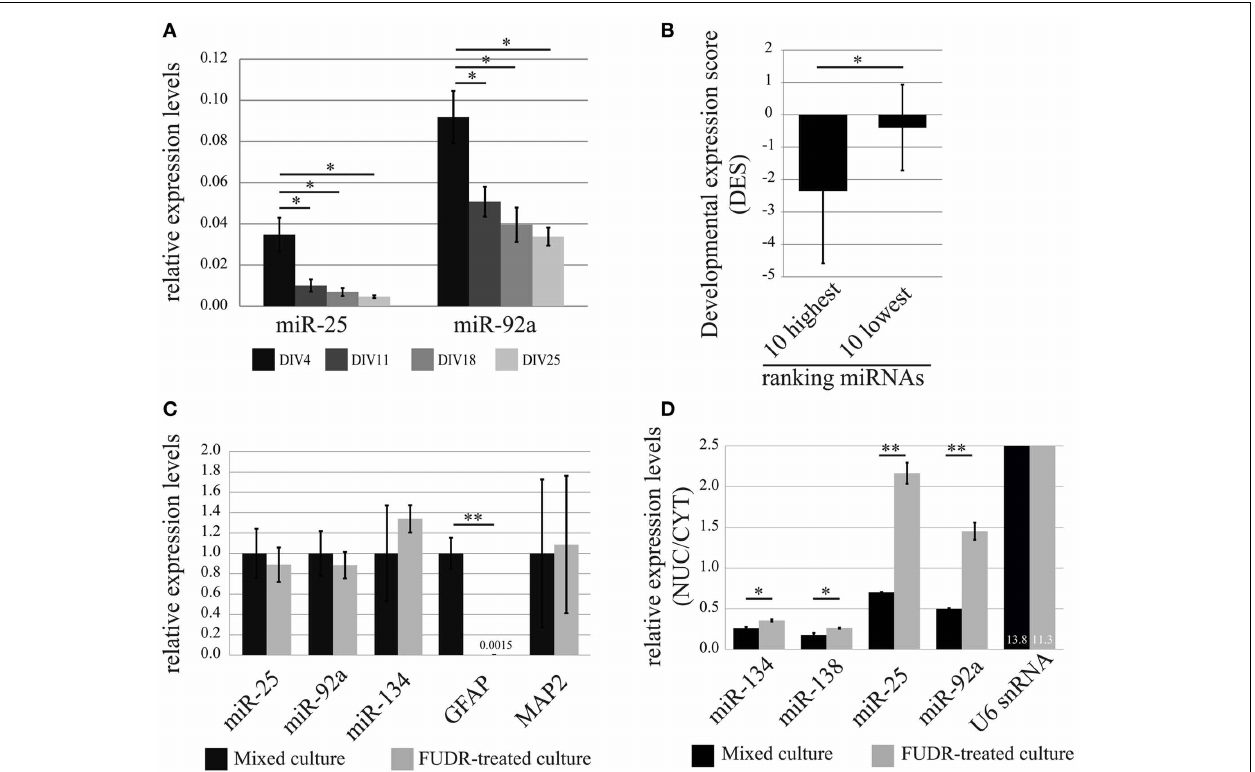
FIGURE 6 | Developmental stage and cell-type-specific expression of the nuclear-enriched miRNAs, miR-25 and miR-92a. (A) Relative expression (normalized to U6 snRNA) levels of miR-25 and miR-92a during in vitro development of primary cortical neurons was determined by qRT-PCR analysis. Bar plots show mean ± SD ( n = 2). Statistical significance was determined using Student’s t -test with Bonferroni correction ( ∗ , p < 0 . 05). (B) Developmental expression score (DES; log 2 (P3/E10) from (Yao et al., 2012); y-axis) comparison of 10 highest and lowest ranked miRNAs. Error bars represent standard deviation from the mean DES within each group. Statistical significance was determined using Student’s t -test ( p = 0 . 028). (C) Expression of miR-25 and miR-92a in mixed cultures and